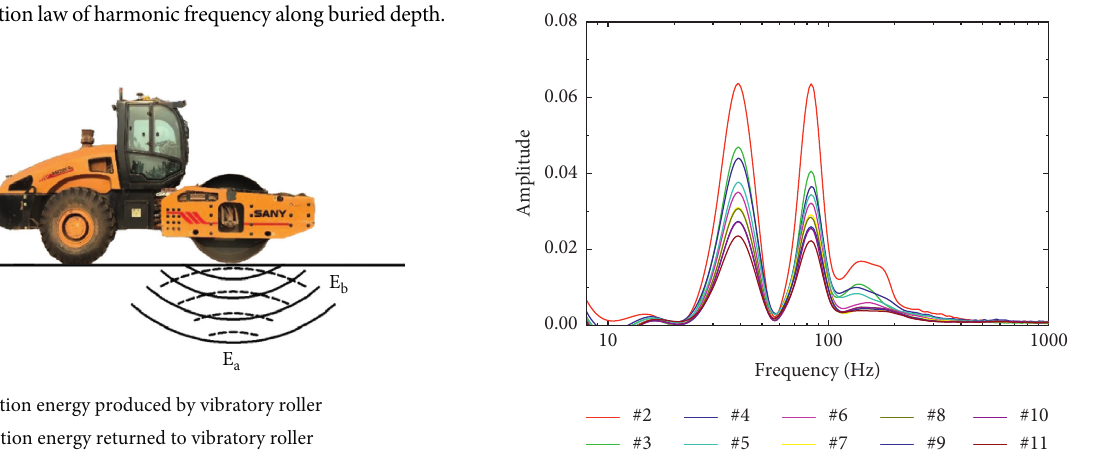
Figure 12: Energy interaction between vibratory roller and surface of filling material.